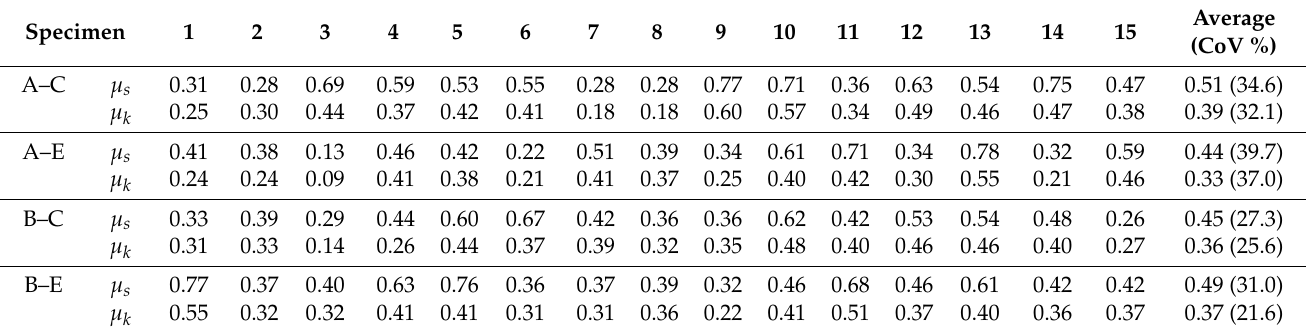
Table 2. Coefficients of friction between timber surfaces at 12% MC. (CoV: coefficient of